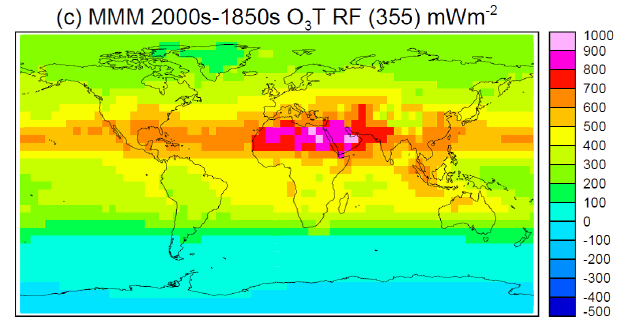
Figure 30. The global distribution of (annual mean) tropospheric ozone (O 3 T) radiative forcing (1850–2000, net SW + LW, includ- ing stratospheric adjustment, in mWm − 2 ) , based on results from the multi-model mean (MMM) of the ACCMIP models, using the Edwards–Slingo radiation scheme (Stevenson et al., 2013). (NB: the value of 0.355Wm − 2 shown here compares to the recommended IPCC value for the 1750–2010 O 3 RF of 0.40Wm − 2 ; the IPCC value includes the additional time periods 1750–1850 and 2000– 2010 (see Myhre et al., 2013, for